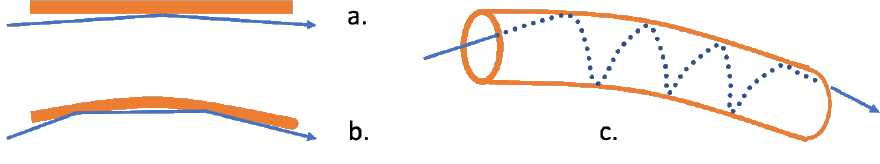
Figure 4. Grazing small-angle reflection ( a ) applied for curved surfaces ( b ) permits radiation bending over large angles via multiple small-angle reflections. This principle is even more efficient for bent capillaries ( c